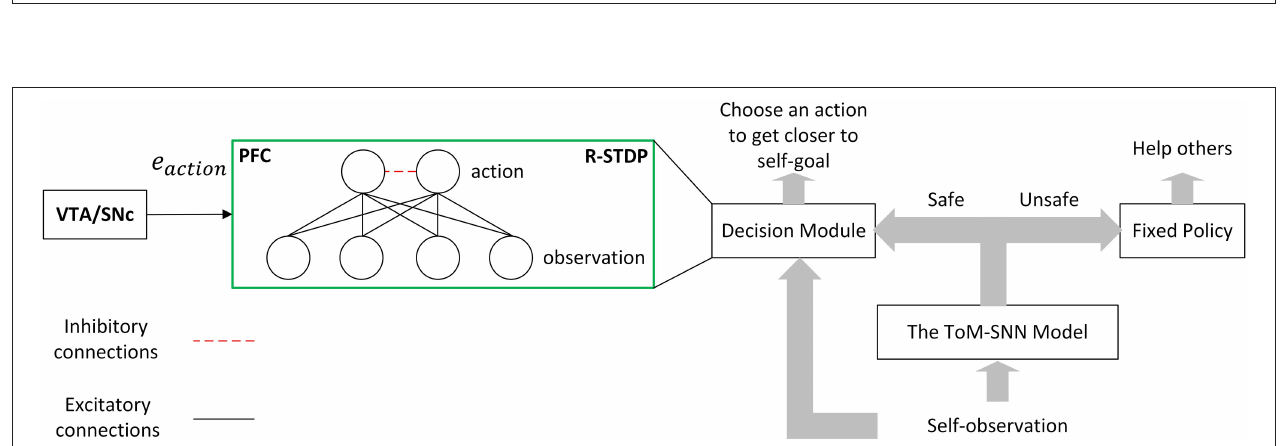
FIGURE 2 | The architecture of the ToM-SNN model. The ToM-SNN model comprises the perspective taking module, the policy inference module, the action prediction module, and the state evaluation module, which are inspired by the TPJ, the vmPFC, the dlPFC, and the ACC, respectively. The perspective taking module parses current observation to form predictions about other’s observation, ˆ o t other . The policy inference module parses current observation and past observation to infer other’s behavior style, ˆ bs other . The action prediction module parses predictions about other’s observation and behavior styles to form other’s predicted action, ˆ a other . When combining predictions about other’s actions with environmental information, the agent can get other’s next state, ˆ s other . The state evaluation module parses other’s next state to form state value, ˆ V other . The arrow in the figure indicates information transmission and does not involve the learning of network weight.